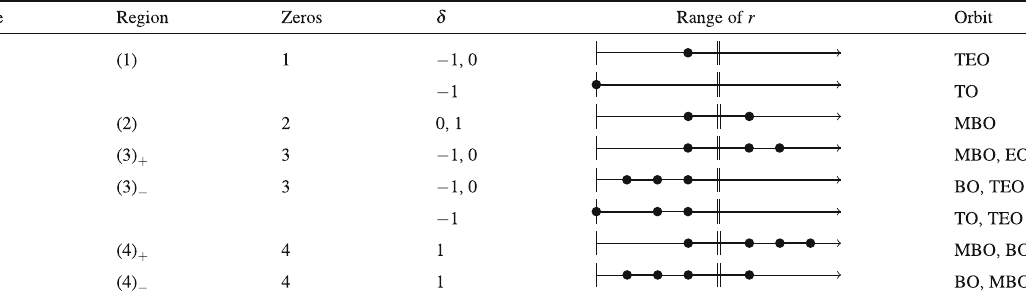
Table 1 Types of orbits of light and particles in the spacetime of a supersymmetric AdS 5 black hole. Thick lines represent the range of the orbits and thick dots indicate their turning points. The vertical double line represents the horizon. The vertical single line corresponds to the